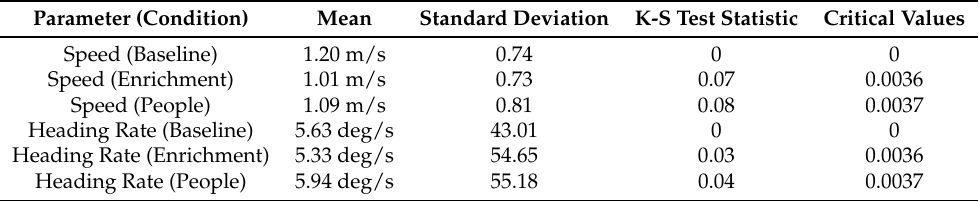
Table 1. Summary measures calculated from the tracklets for the three conditions (baseline, enrich- ment, and people). Mean, standard deviation, and the results of the K-S tests are reported. The enrichment and people conditions are compared with Baseline in the K-S tests.